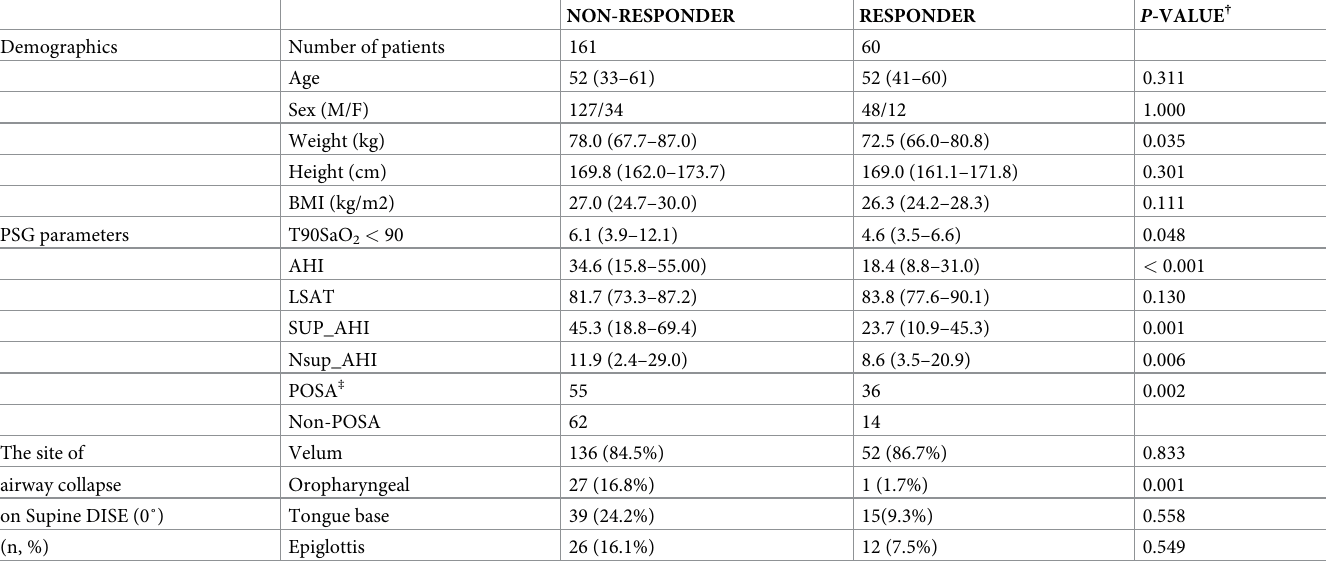
Table 3. Comparison of baseline characteristics between responders and non-responders to head rotation maneuver �